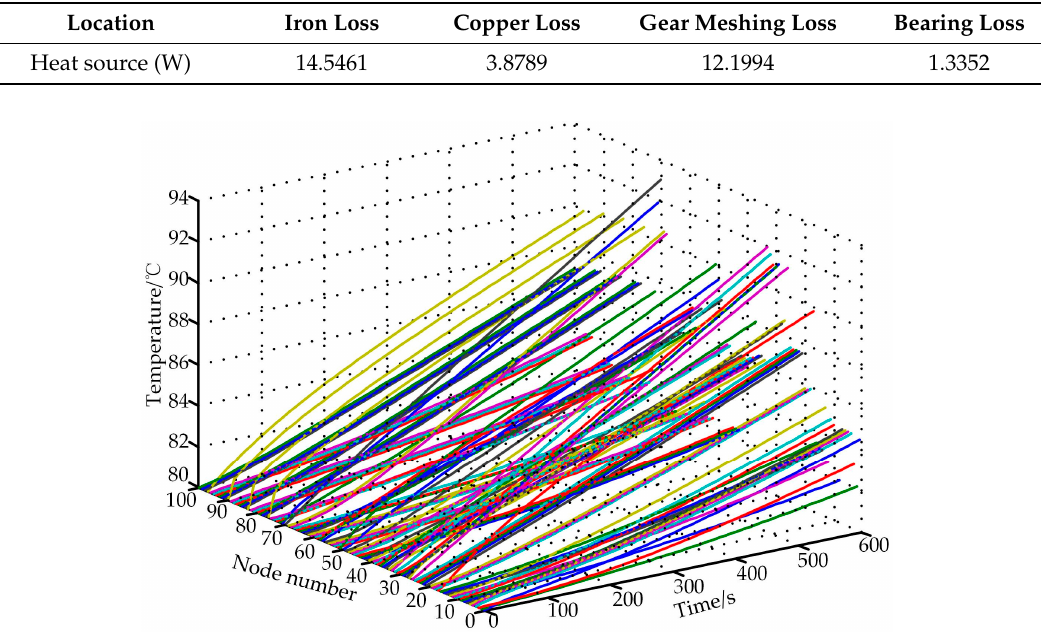
Figure 6. Inner temperature field after 10 min.